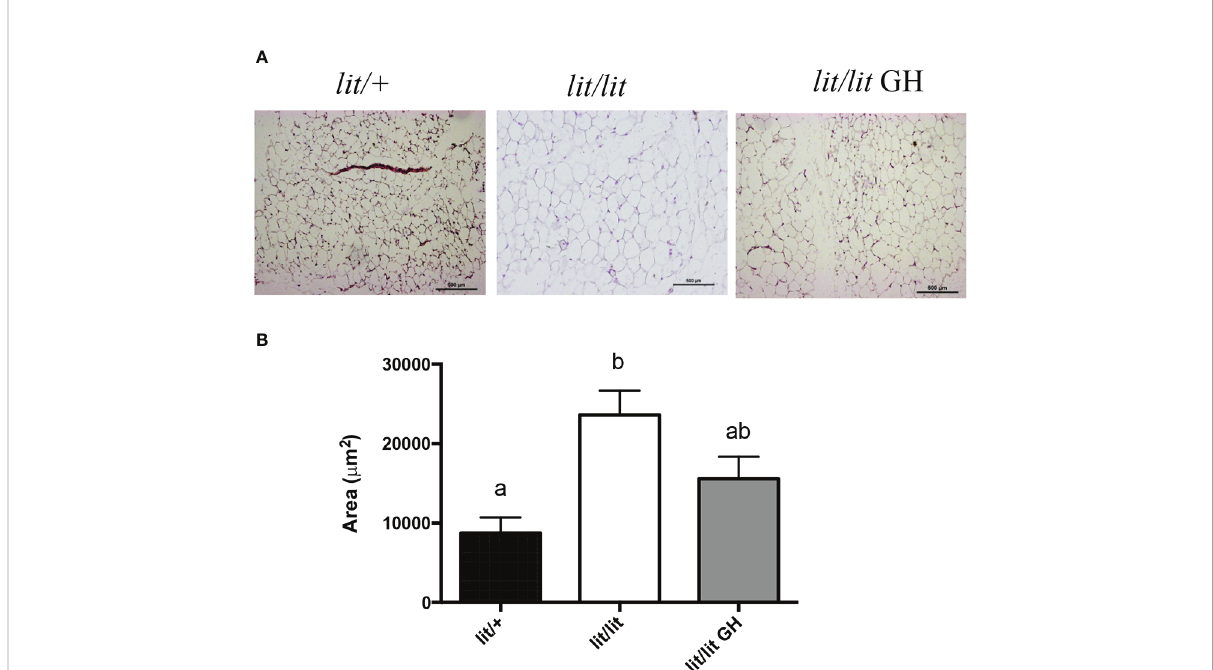
FIGURE 2 Effects of GH de fi ciency and GH injection on average adipocyte size in mice. Three groups of 9-week-old male lit/lit, lit/lit , and lit/+ mice from the same litters were injected with GH, vehicle control, and vehicle control, respectively, once a day, for 4 weeks. Inguinal subcutaneous fat pads were collected at the end of the experiment for sectioning and staining. (A) Representative micrographs of fat sections. (B) Average adipocyte size. Data are expressed as means ± SEM (n = 5 mice). Means not sharing the same letter label are statistically different ( P <